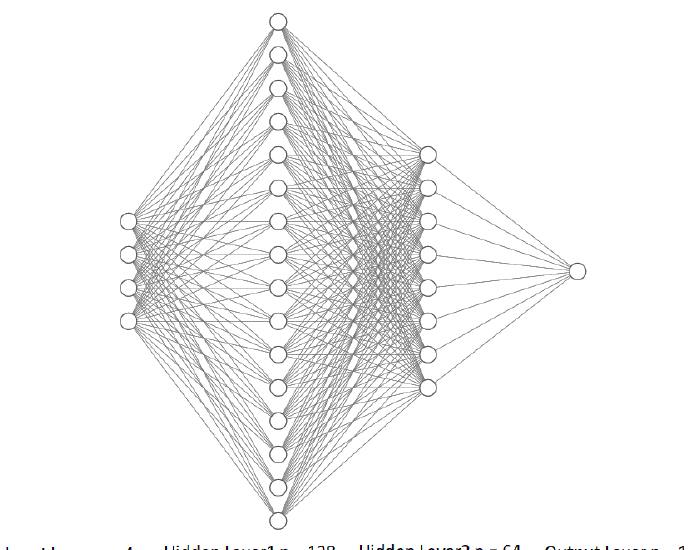
Figure 3. The architecture of ANN used in this